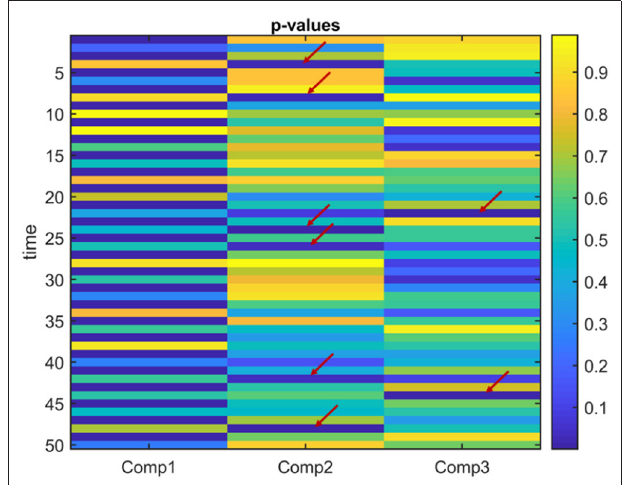
FIGURE 8 | Case 2. p -values obtained using the two-sample t -test on the subject-mode patterns ( A k ) using IVA. IVA successfully captures that the first component is statistically significant in terms of group difference in every other window. In the other components, in some time windows, there are false positives marked with a red arrow.